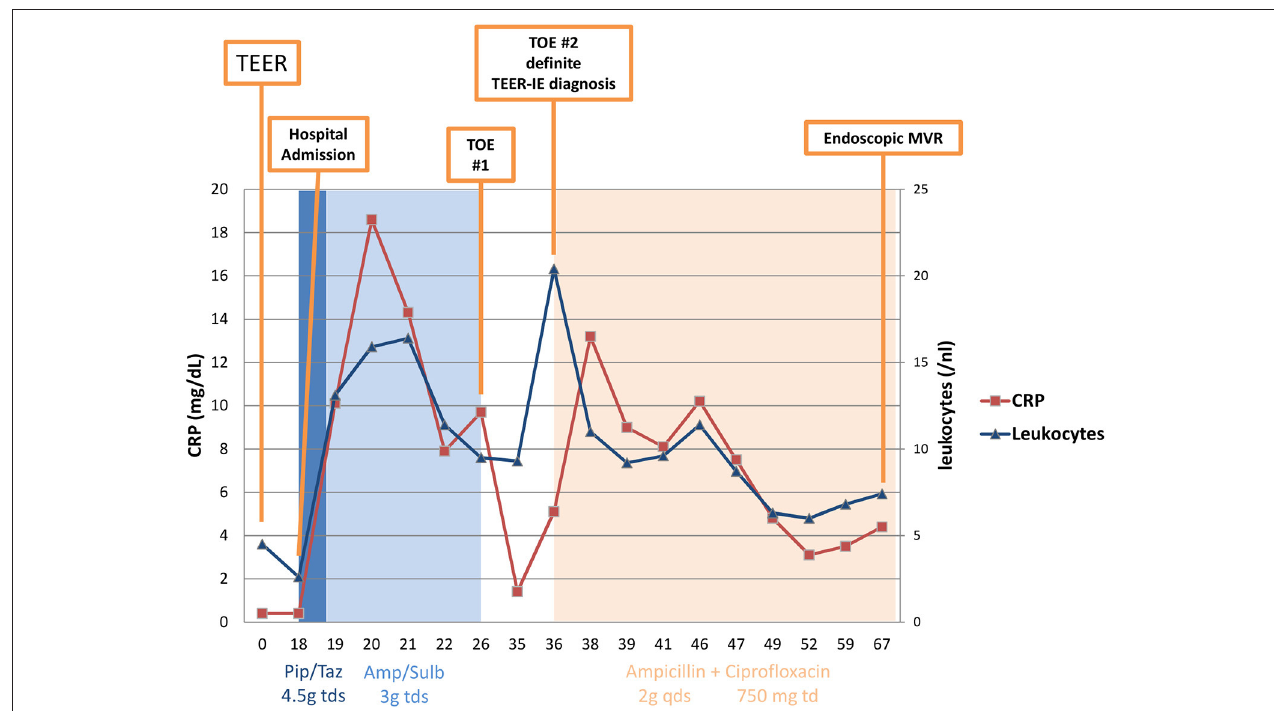
FIGURE 3 | C-reactive protein and leucocytes over the clinical course of infective endocarditis. TEER, transcatheter edge-to-edge repair; TOE, transesophageal echocardiography; IE, infective endocarditis; MVR, mitral valve repair; Pip/Taz, piperacillin/tazobactam; Amp/Sulb, ampicillin/sulbactam; tds, three times a day; qds, four times a day; td, twice daily; CRP, C-reactive protein.